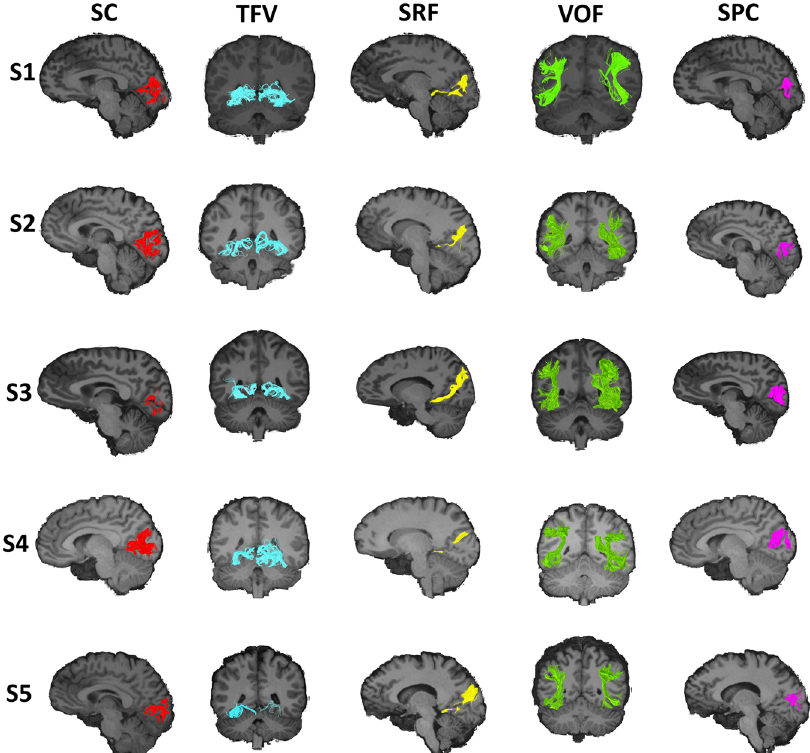
Fig. 7 Intralobar fi bers in the occipital lobe presented in individual subjects. Representation of the identi fi ed occipital intralobar tracts in fi ve of the 24 subjects used in this study. The same methodology and regions of interest (ROIs) used to isolate the tracts in the group averaged tractography data. The ROIs were wrapped to native subject spaces. This generates tractography fi ndings that support the presence of the tracts in distinct individuals and depict the subject speci fi c trajectory of the intralobar tracts. VOF vertical occipital fasciculus (green), SRF sledge runner fasciculus (yellow), SPC stratum proprium cunei (magenta), SC stratum calcarinum (red), TFV putative transverse fasciculus of the lingual lobule of Vialet